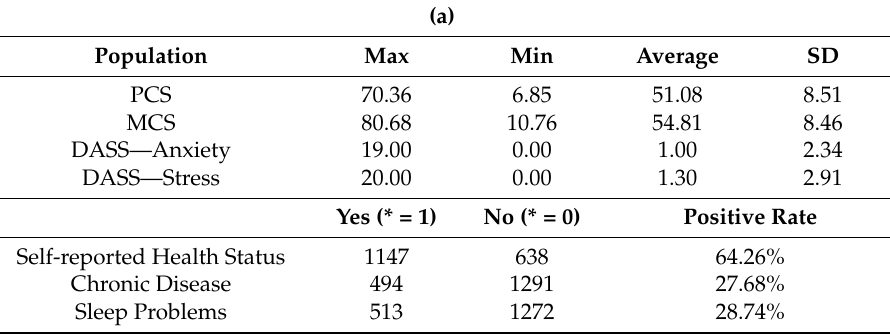
Table 1. (a) Health measures among the whole population. (b) Health measures among the middle- to low-income